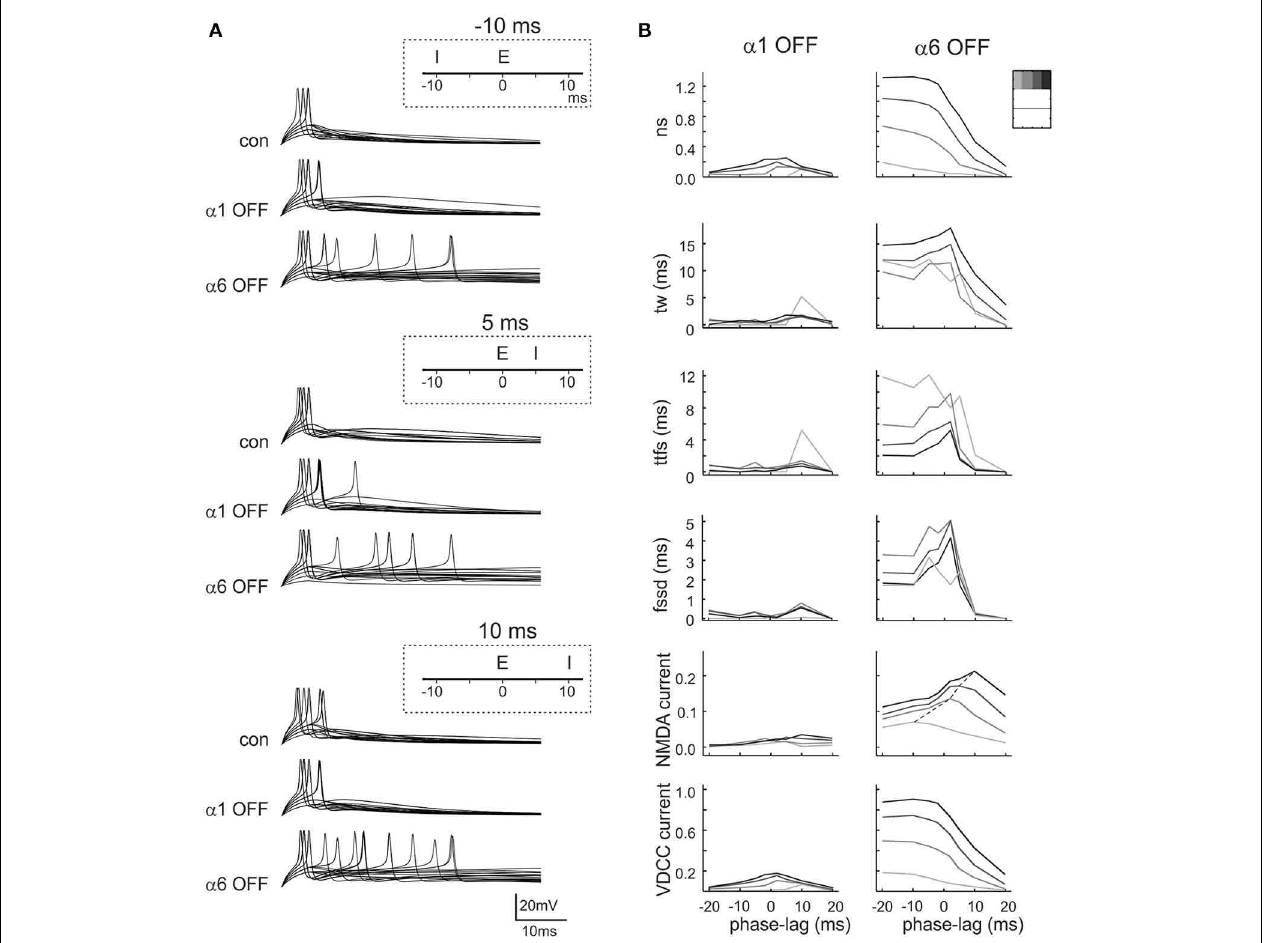
FIGURE 7 | Effect of phasic inhibition on granule cell response with variable E/I phase. (A) Exemplar simulations of inhibition occurring at different phases compared to excitation (E/I phase lag of − 10, 5, 10ms, as indicated in the insets) in control and after α 1 or α 6 receptor switch-off. (B) The plots show the changes of number of spikes ( ns ), time window ( tw ), time to first spike ( ttfs ), first spike standard deviation ( fssd ), VDCC currents